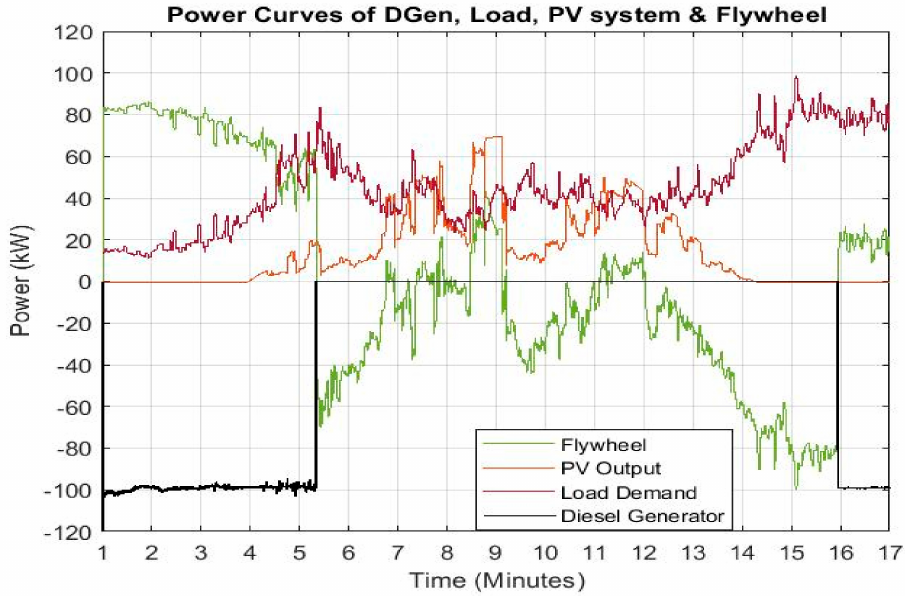
Figure 28. Combined power curves of Load, PV system, Flywheel and DGen.